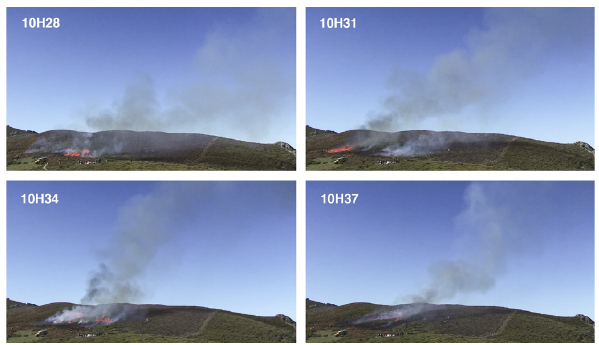
Fig. 6. Actual photographs of the smoke plume at different steps of the burning experiment.